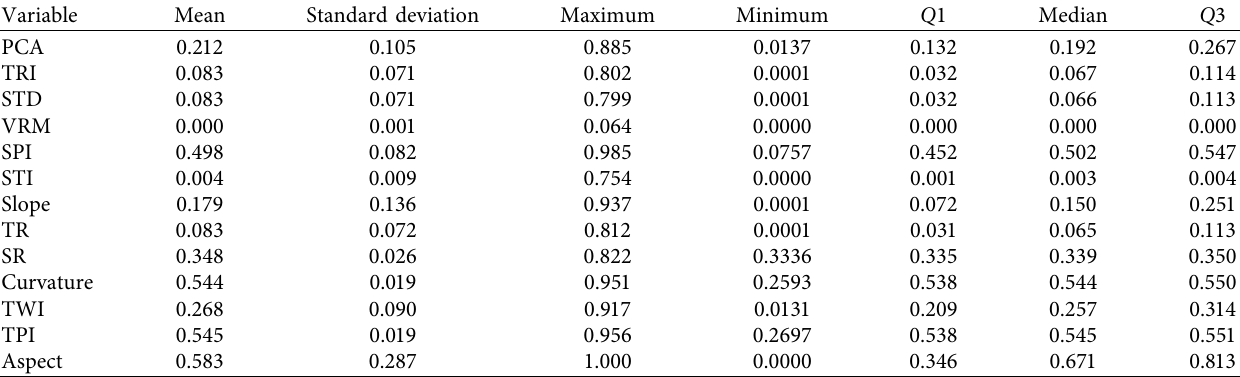
Table 2: Descriptive statistics of the selected dataset.